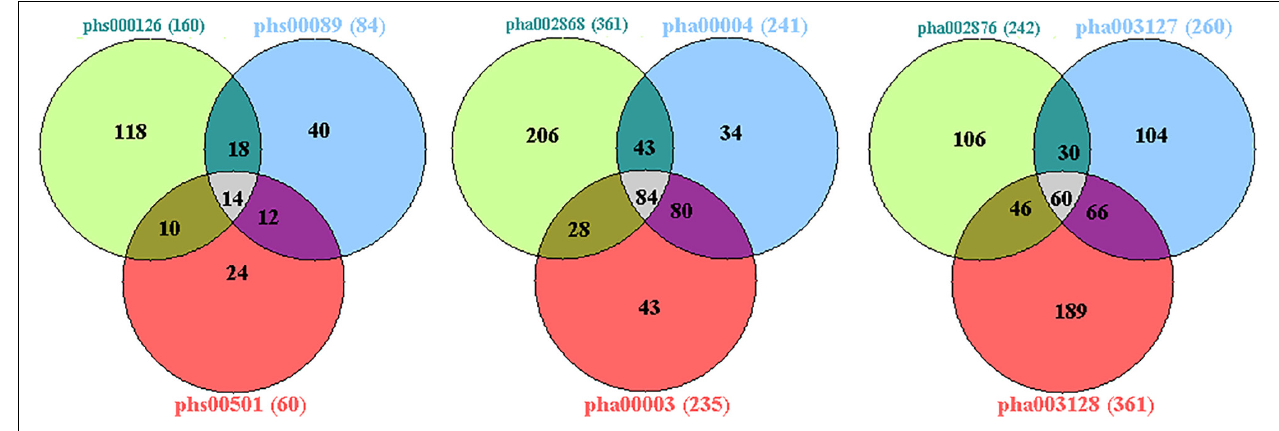
FIGURE 3 | Venn diagram analysis of the four GWAS datasets. There were 43,474 candidate genes with at least one genotyped locus in study 1; 44,304 candidate genes in study 2; 43,699 candidate genes in study 3; and 41,458 candidate genes in study 4. There were 2,779 overlapping candidate genes between the four datasets by Venn diagram analysis; based on a nominal threshold p -value < 0.01, we identified 52 genes that were significantly associated with sPD. GWAS, genome-wide association study; sPD, sporadic Parkinson’s